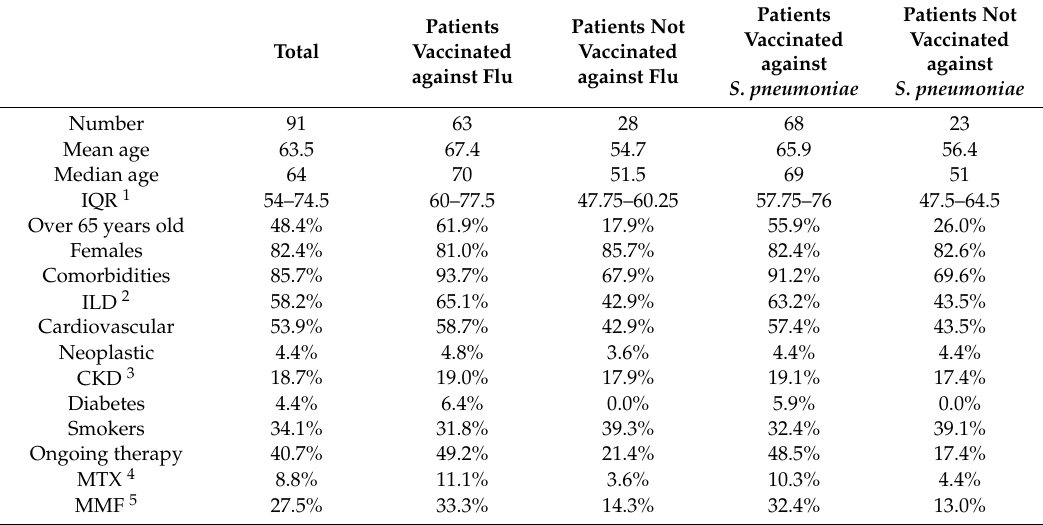
Table 1. Clinical and demographic characteristics of systemic sclerosis (SSc)